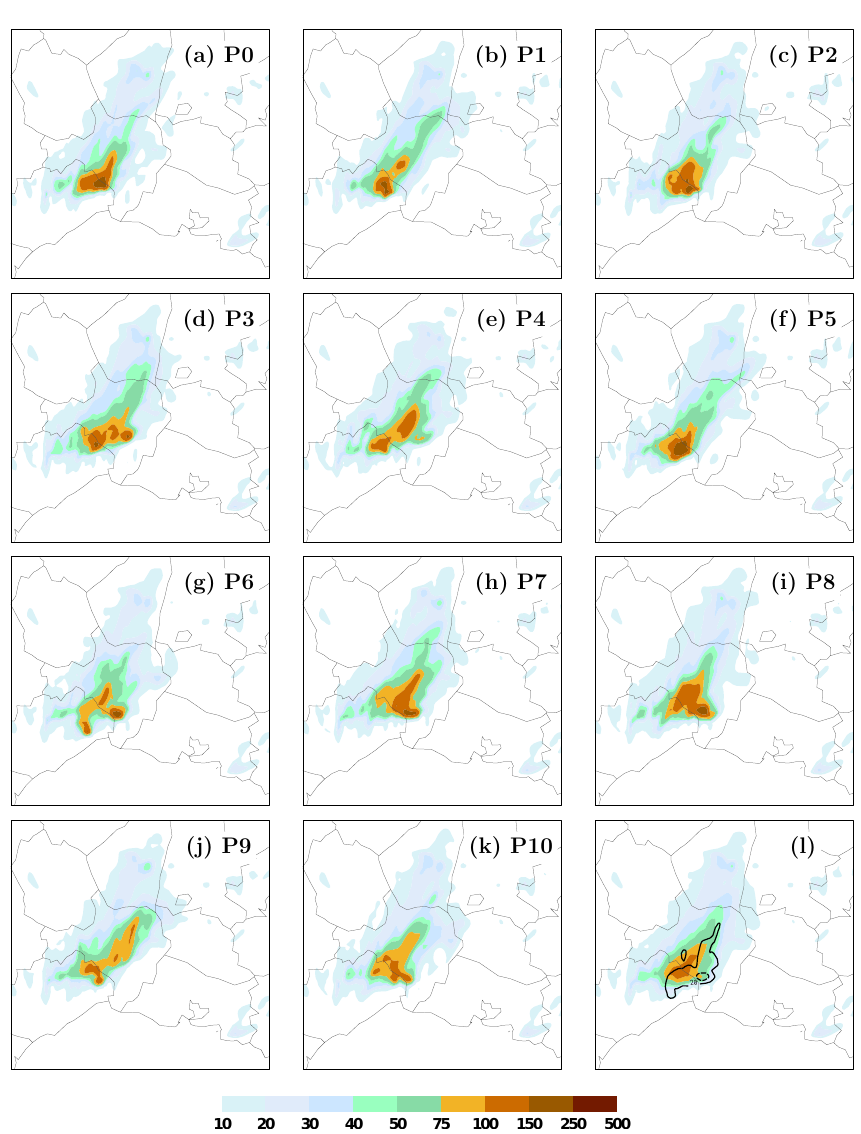
Fig. 9. 24-h accumulated precipitation forecasts (mm) for Case 1, at 00:00 UTC 21 October 2008, from each member of the E5 ensemble. Panel (l) shows the ensemble mean (colour shading) and 20mm (solid) and 50mm (dashed) standard deviation